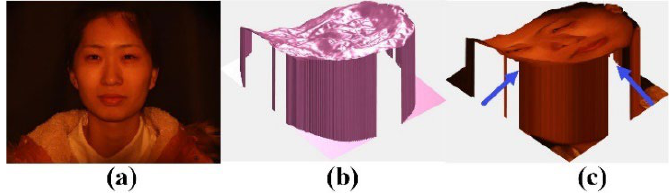
Figure 3. Example of deformation caused by ambiguous azimuth, ( a ) Directly captured human face, ( b ) Depth map and ( c ) recovered 3D face deformation caused by ambiguous azimuth.